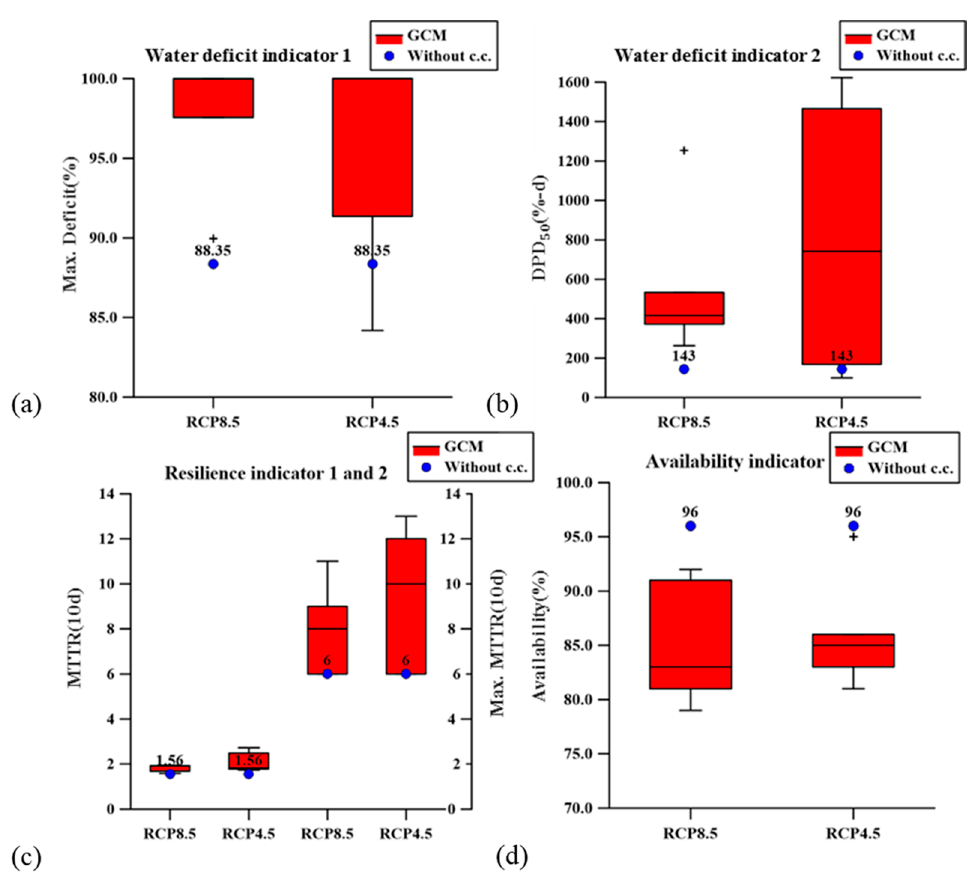
Figure 10. Values of Max. R ( a ), DPD 50 ( b ), MTTR and Max. TTR ( c ), and Availability ( d ) for water shortage of Formosa Plastics Corporation (FPC) in 2021–2040.